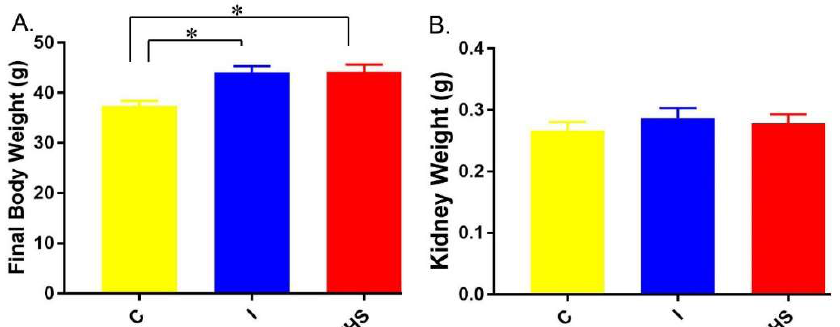
Figure 3. Body and kidney weights—( A ) Final mean body weights in the three groups; ( B ) final kidney weights (average right and left kidneys); * indicates a significant ( p < 0.05) difference between groups (mean ± sem, n = 11–12/group).